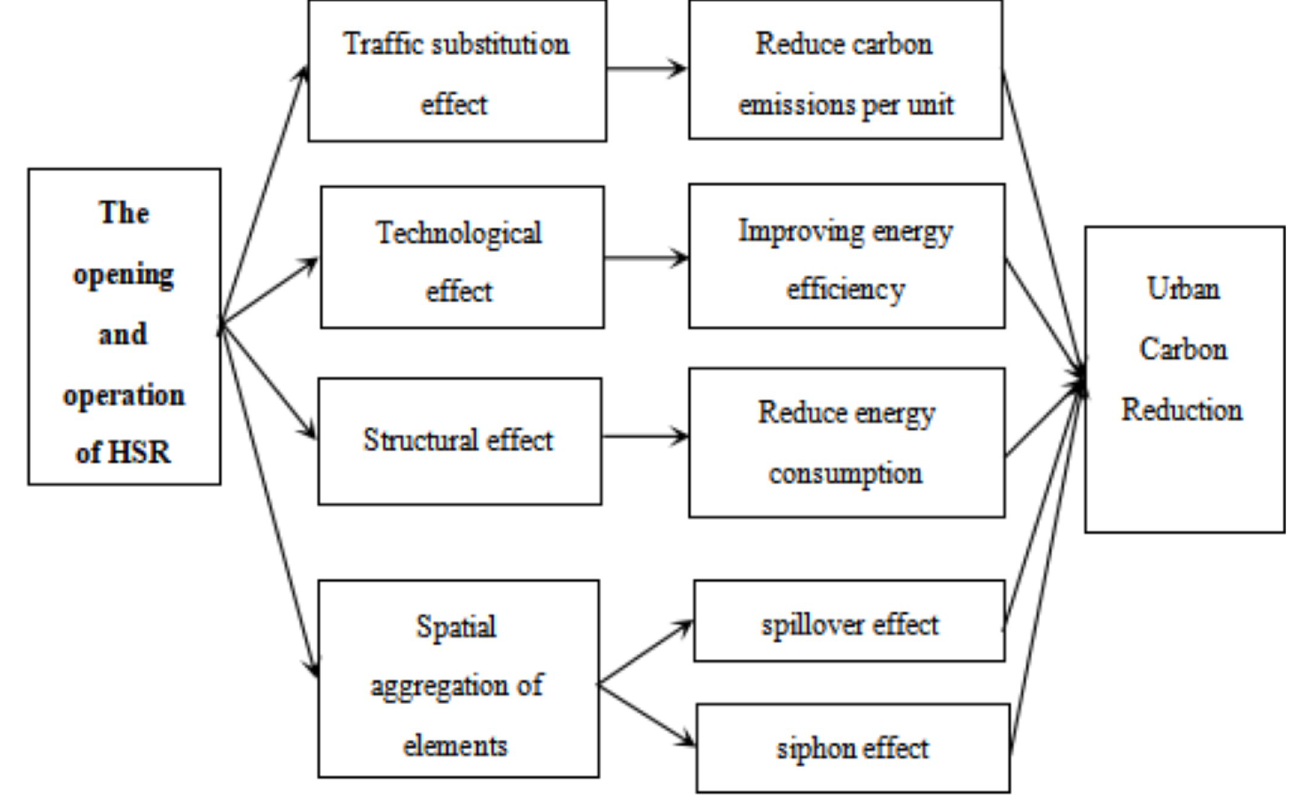
Fig 1. Mechanism